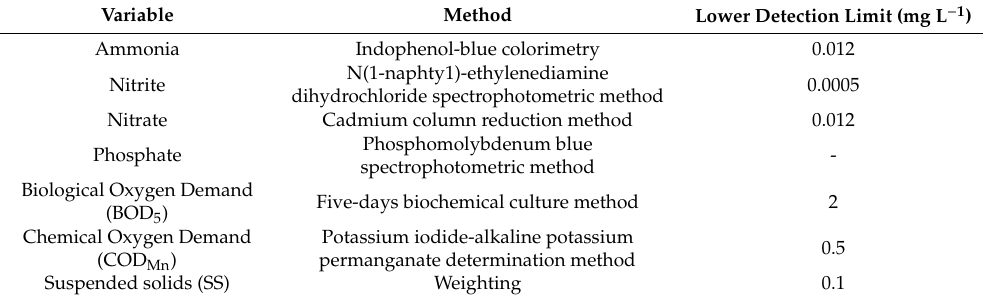
Table 1. Methods used for seawater analysis in Yundang Lagoon. All methods are according to the national standard GB17378.4